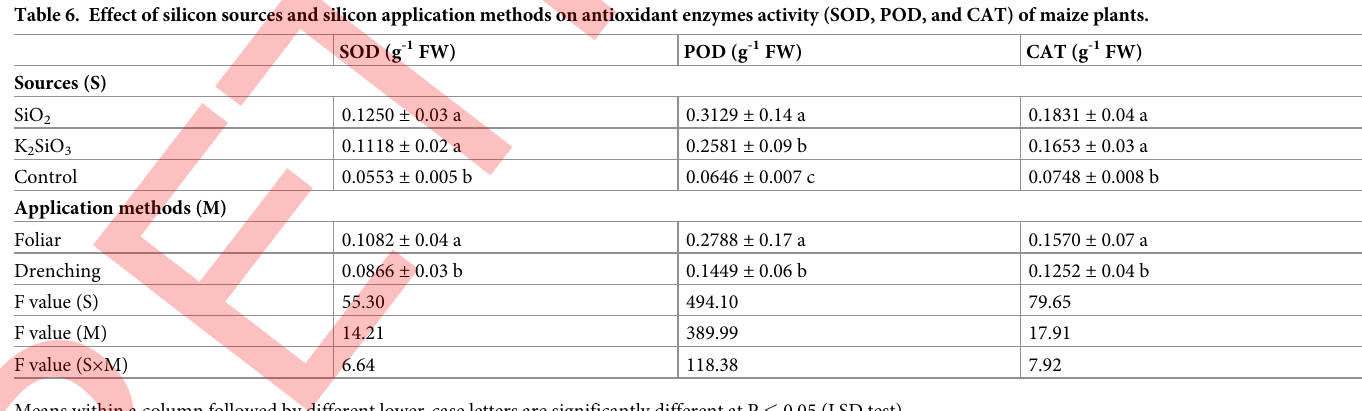
Table 6. Effect of silicon sources and silicon application methods on antioxidant enzymes activity (SOD, POD, and CAT) of maize plants. SOD (g -1